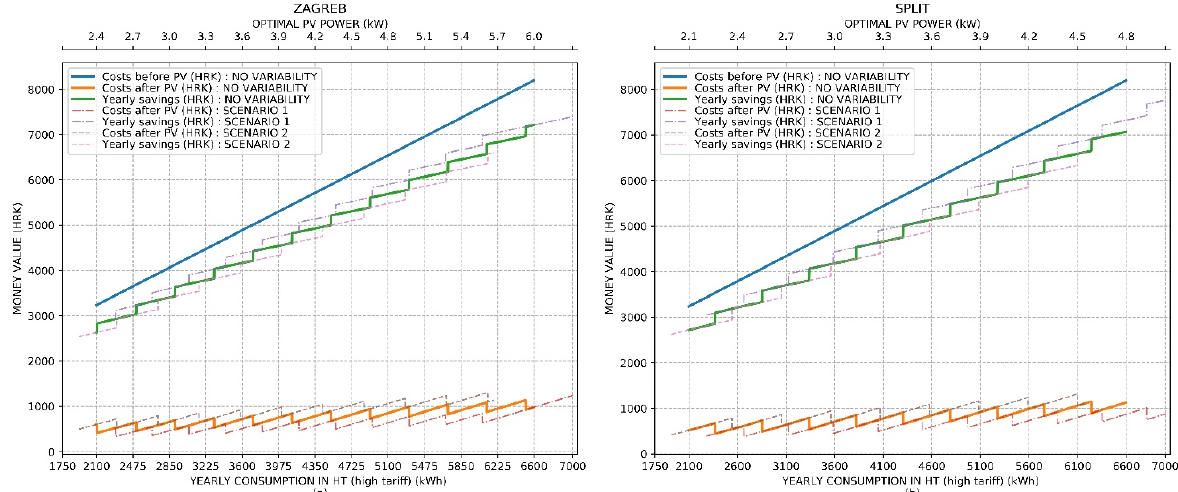
Figure 10. Simulation results for electricity costs and savings before and after the installation of the PV system. ( a ) Simulation results for Zagreb. ( b ) Simulation results for Split.